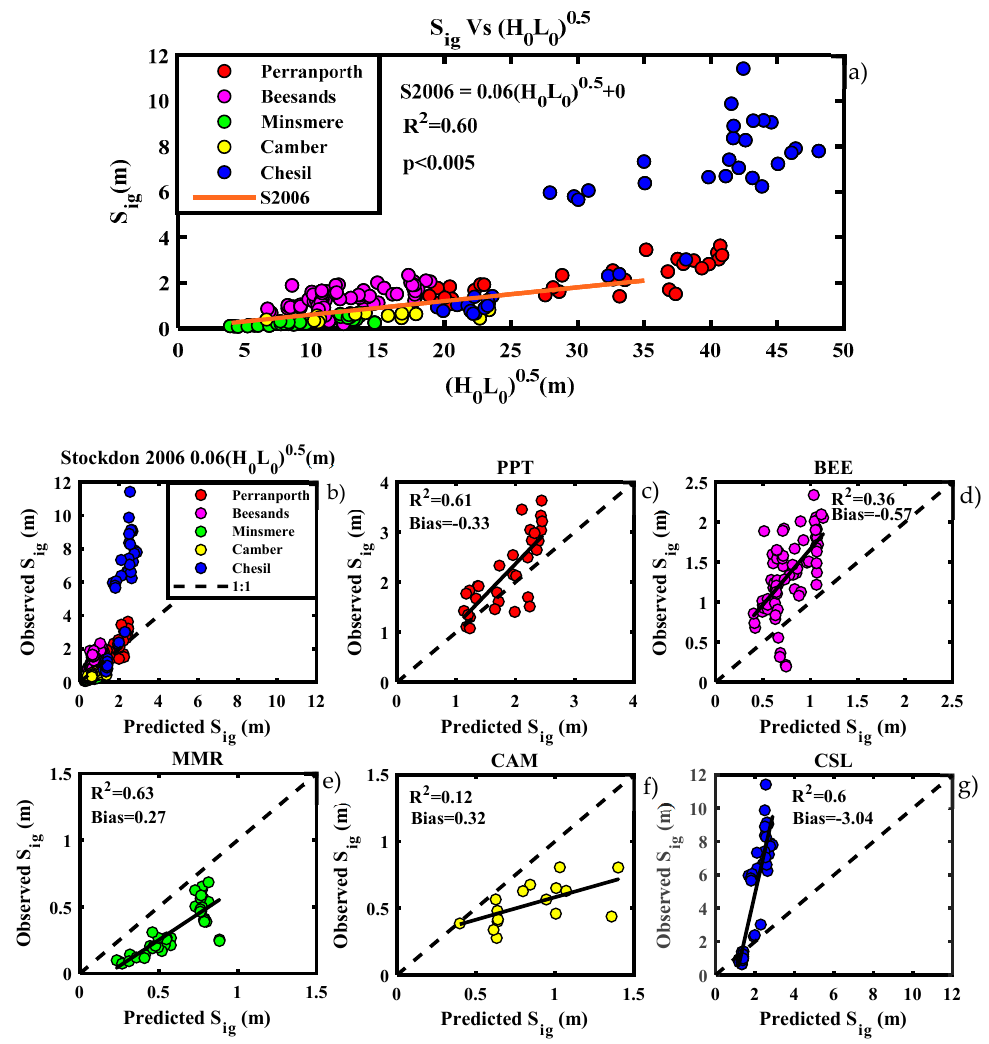
Figure 7. ( a ) Significant infragravity swash height S ig against (H 0 L 0 ) 0.5 after Stockdon et al. (2006). Linear best fit for Stockdon 2006 data (solid orange line), limited to the original range of (H 0 L 0 ) 0.5 . ( b ) Comparison of S ig heights observed and those predicted by S2006 at all sites. ( c – g ) As above but for individual sites.